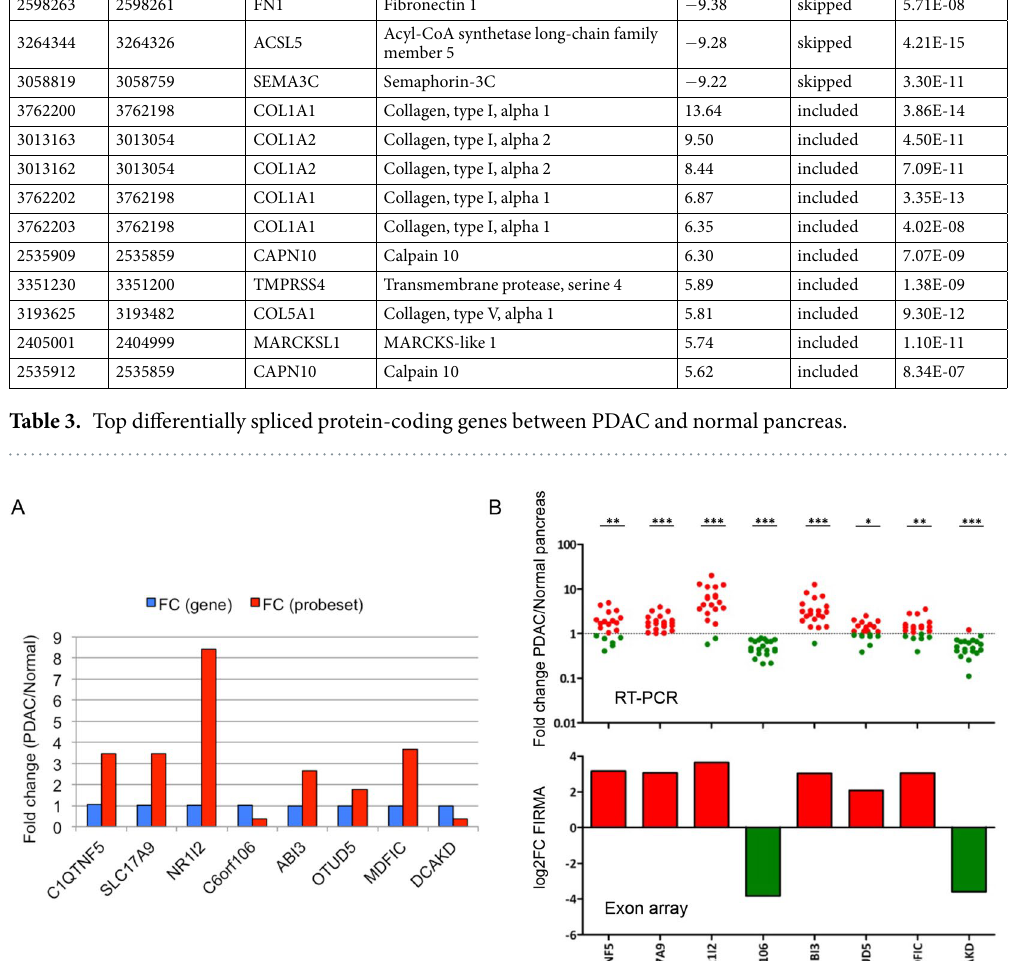
AS and DE events that affect cell surface proteins might represent an exciting opportunity for their use as biomarkers for detection and/or as therapeutic targets. A total of 135 cell surface protein-coding genes that are regulated at both gene expression and alternative splicing level are listed in Supplementary Table S3D. The splicing pattern of two genes encoding the cell surface proteins, ROBO1 (an axon guidance gene) and LRP8 (Low Density Lipoprotein Receptor-Related Protein 8, which plays a critical role in the migration of neu- rons during development), were assessed by real-time PCR (Fig. 5). ROBO1 and LRP8 displayed multiple splicing events according to FIRMA prediction (Supplementary Fig. S4) and were upregulated in PDAC compared to